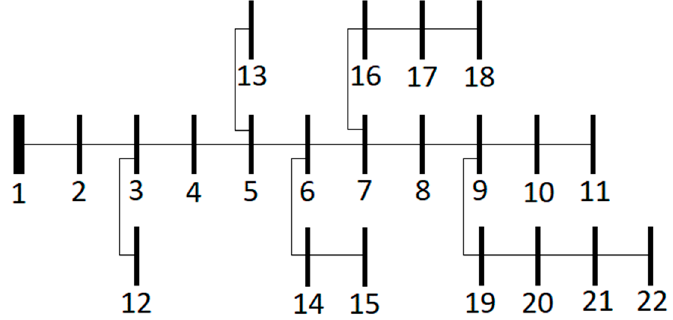
Figure 1. Breshna Kot distribution network model. Table 1. Kabul city 20 kV distribution system transmission line parameters.